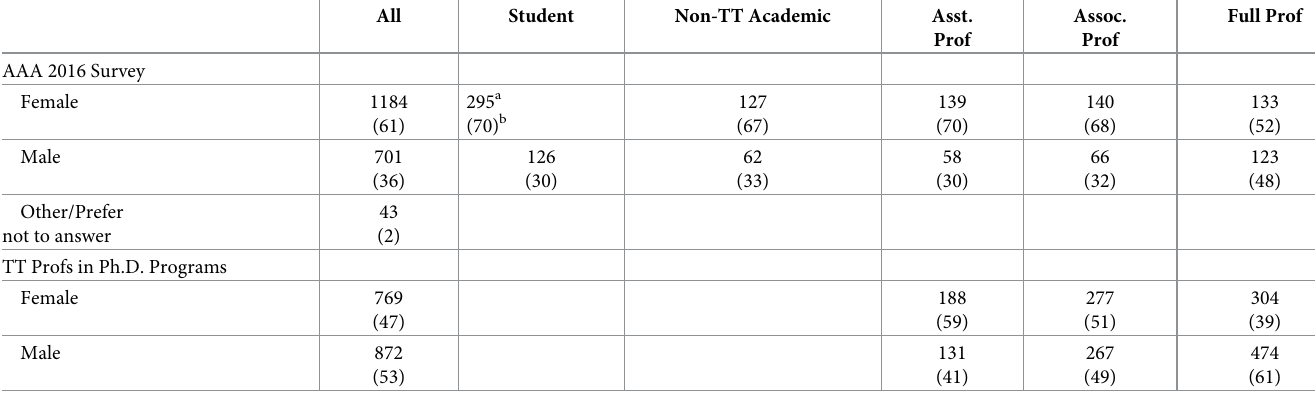
Table 1. Gender and academic rank for 2016 AAA survey and meeting presenters.